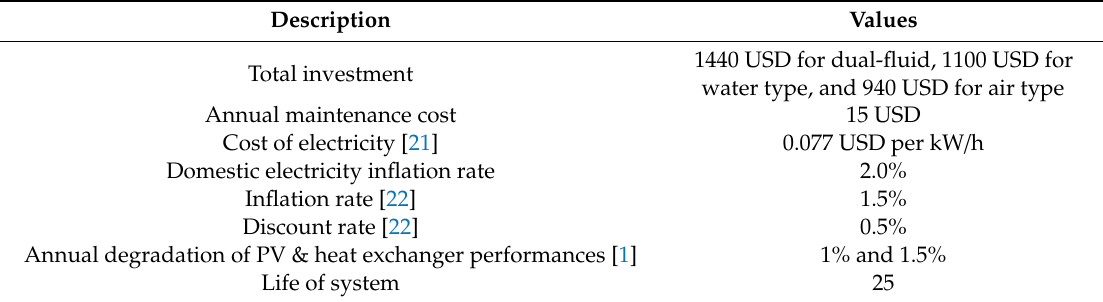
Table 4. Parameters for life cycle cost analysis.